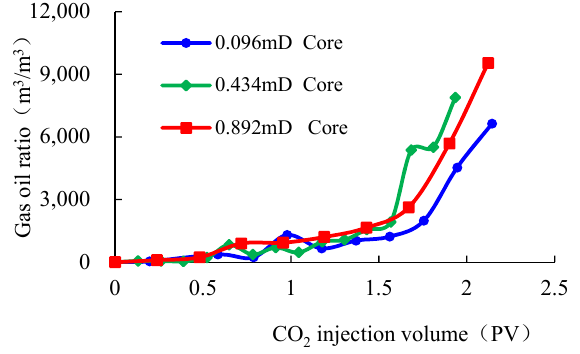
Figure 7. The gas–oil ratio of cores with different permeability under miscible conditions. With an increase in CO 2 injection volume, the recovery degree of core immiscible flooding increases. However, when the injection volume exceeds 0.5 PV, the increment of recovery degree gradually decreases. The greater the core permeability, the higher the recovery degree of immiscible flooding becomes (Figure 8). A CO 2 injection volume of 0.0 to 0.5 PV is the stage of gas-free production, and the stage of gas breakthrough is 0.5 PV~1.3 PV. The CO 2 gas channeling of immiscible displacement is faster than that of miscible displacement. The gas–oil ratio is less than 2000 m 3 /m 3 . After injecting about